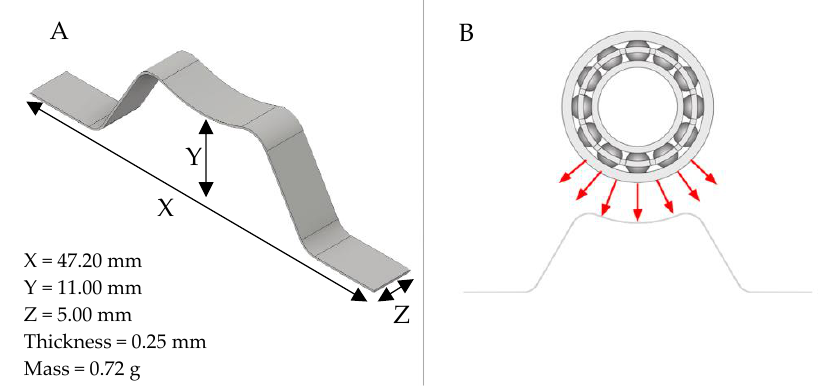
Figure 2. ( A ) M-Shape device of SMA-SE; ( B ) distribution of the forces on the M-Shape device.